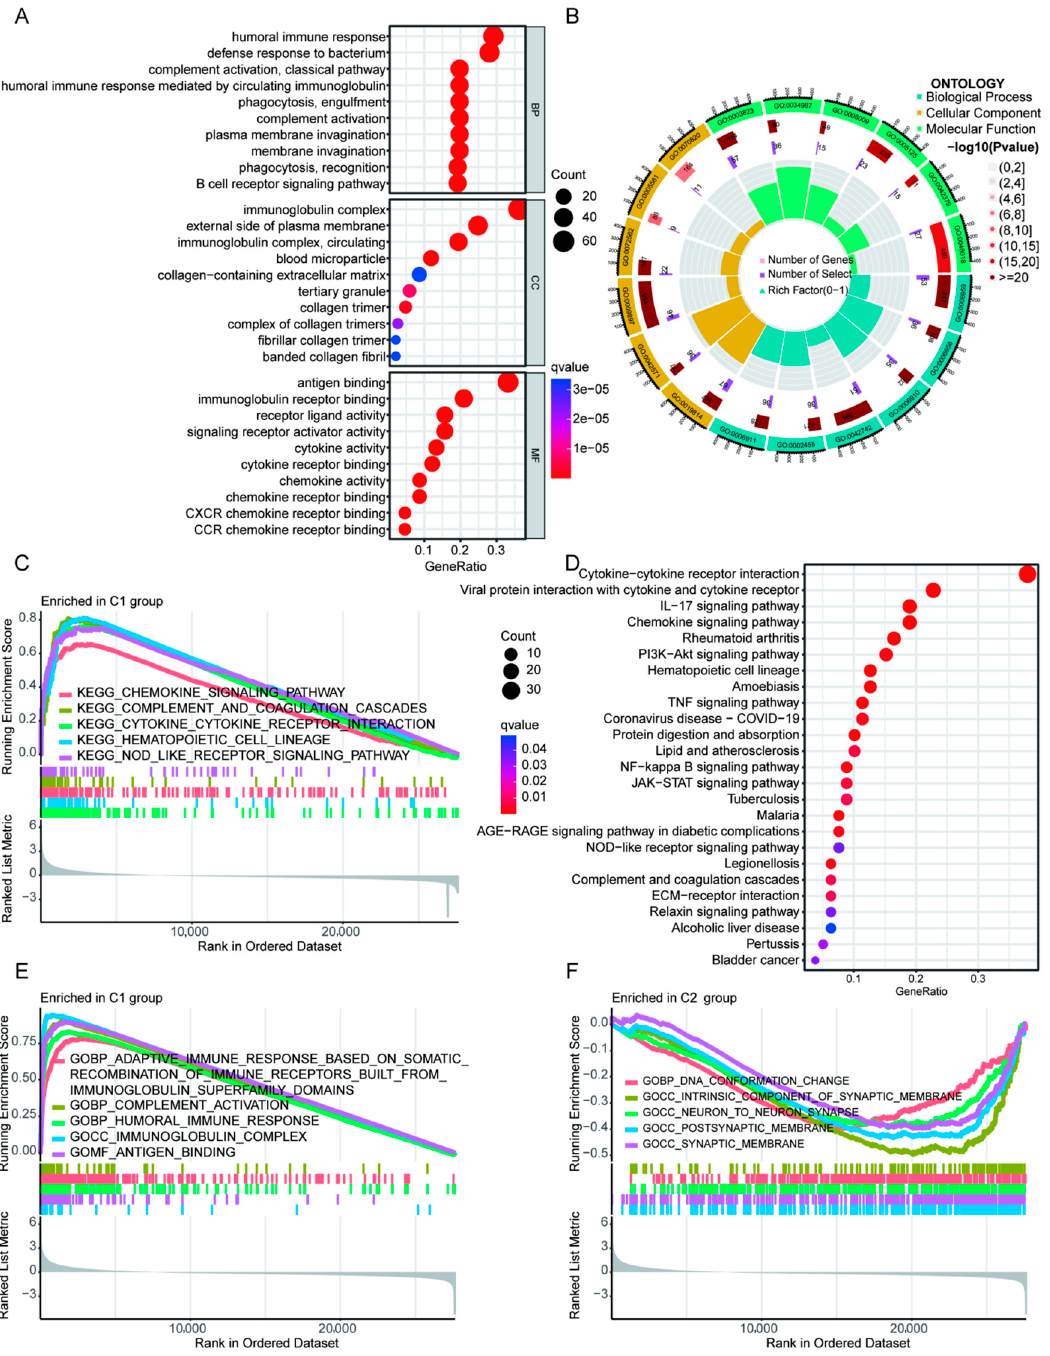
Figure 3. Enrichment analysis of DEGs in ICD genotyping of HGGs. ( A , B ) GO enrichment analysis in different ICD genotyping. ( C ) KEGG enrichment analysis in C1 group. ( D ) KEGG enrichment analysis in different ICD genotyping. ( E , F ) GO enrichment analysis in C1 and C2 groups, respec- tively.